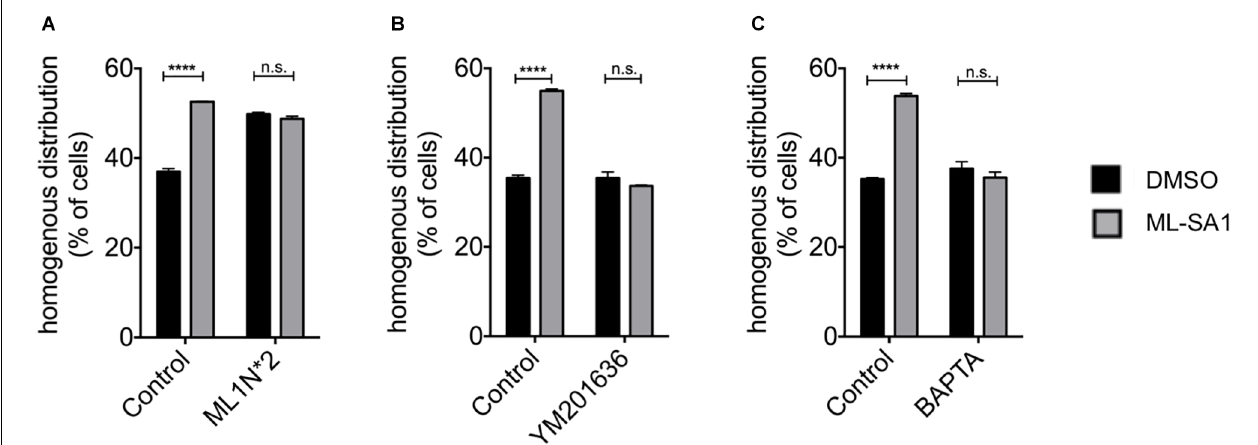
FIGURE 2 | TRPML-1-Agonist ML-SA1 requires Phosphoinositides (PIs) and Ca 2+ . (A) HEK293T cells were transfected with GFP-tagged A53T- α -synuclein, and in addition with ML1N*2 (the N-terminus of TRPML1), which binds PI(3,5)P2, or mCherry only as control and treated in addition with 25 µ M ML-SA1 or DMSO starting 6 h after transfection for 18 h. GFP distribution patterns were determined in n = 3 independent experiments. Only the percentage cells with a homogenous GFP distribution are shown for clarity. Two-way ANOVA (factors transfection and treatment) showed significant interaction ( p < 0.0001). Results of Sidak’s multiple comparisons test are depicted. (B) HEK293T cells were transfected with GFP-tagged A53T- α -synuclein and treated with 800 nM YM201636 or DMSO only as control starting 5 h after transfection and with 25 µ M ML-SA1 or DMSO only starting 6 h after transfection. Cells were analyzed 24 h after transfection. GFP distribution pattern was determined. Only the results for homogenous GFP distribution are shown for clarity. Findings are from n = 3 independent experiments. Two-way ANOVA (factors YM201636 treatment and ML-SA1 treatment) showed significant interaction ( p < 0.0001). Results from Sidak’s multiple comparisons tests are depicted. (C) HEK293T cells were transfected with GFP-tagged A53T- α -synuclein and treated with 100 nM BAPTA-AM or DMSO only and with 25 µ M ML-SA1 or DMSO only starting 6 h after transfection. Cells were analyzed 24 h after transfection. GFP distribution patterns were determined in n = 3 independent experiments. Two-way ANOVA (factors BAPTA-AM treatment and ML-SA1 treatment) showed significant interaction ( p < 0.0001). Results from Sidak’s multiple comparisons tests are depicted. **** p < 0.0001, non-significant differences are depicted as